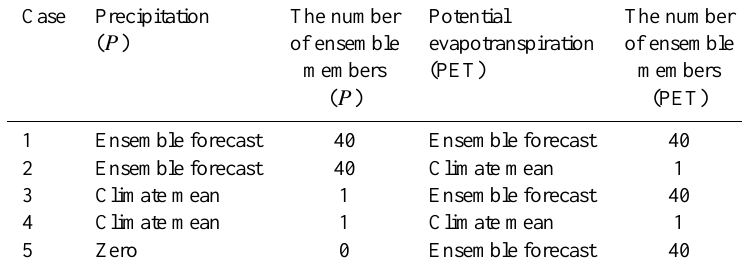
Table 4. Details of the five input cases. Case Precipitation The number Potential The number of ensemble of ensemble